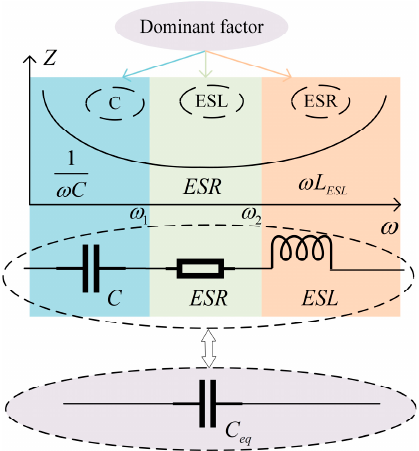
Figure 1. simplified capacitor equivalent circuit and its typical frequency characteristics. Figure 1. Simplified capacitor equivalent circuit and its typical frequency